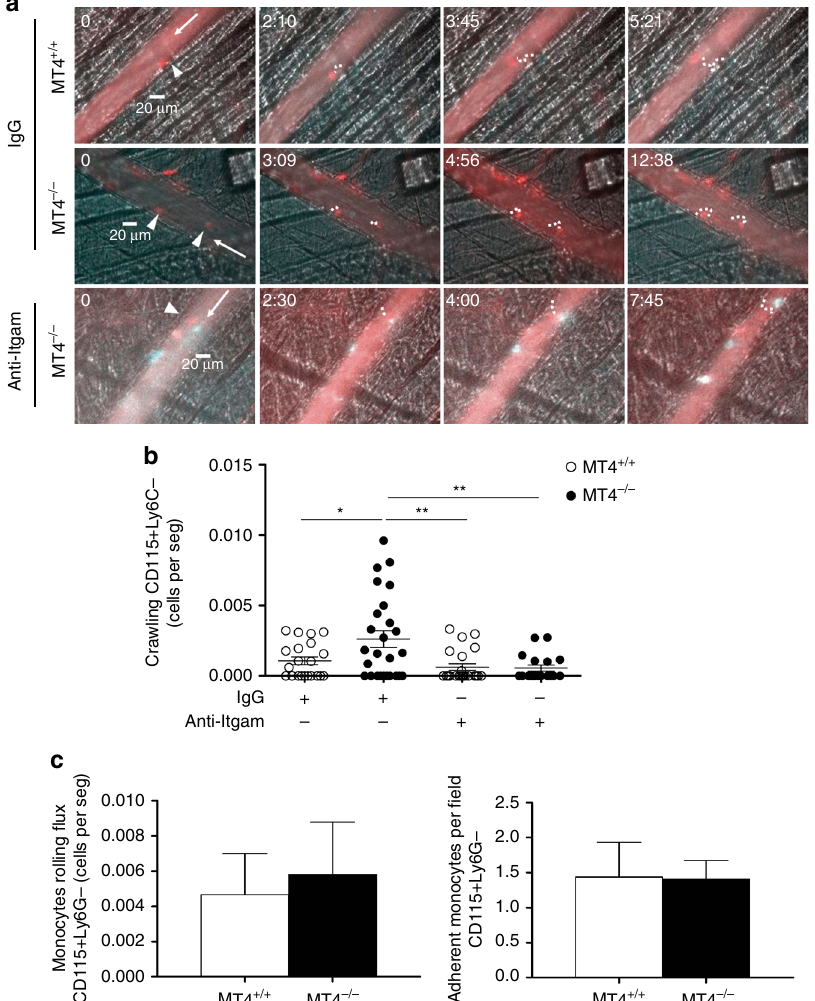
Fig. 4 Enhanced α M integrin-dependent crawling of MT4-MMP-null patrolling monocytes on CCL2-in fl amed endothelium. a Representative intravital microscopy images of CD115 + /Ly6C – patrolling monocytes (CD115 in red and Ly6C in green) crawling on the CCL2-in fl amed endothelium in the cremaster muscle of wild-type (MT4 + / + ) and MT4-MMP-null (MT4 – / – ) mice; the recording was performed in the presence of anti-Itgam blocking antibody (M1/70) or IgG isotype control. Arrowheads, arrows, and dots respectively indicate individual patrolling monocytes, blood fl ow, and monocyte trajectory. Time of recording is indicated. b The graph shows the numbers of crawling patrolling monocytes recorded in a in every venule from fi ve independent mice per genotype and condition in two independent experiments. c Quanti fi cation of CD115 + Ly6G- rolling (left) and adherent (right) monocytes in the CCL2- in fl amed endothelium in the cremaster muscle of wild-type (MT4 + / + ) and MT4-MMP-null (MT4 – / – ) mice. n = 8 mice per genotype in two independent experiments. Data were tested by one-way ANOVA followed by Bonferroni ’ s post test in b and by two-tailed Student ’ s t -test in c . Results are expressed as mean ± SEM.* p < 0.05, ** p < 0.01, and *** p <